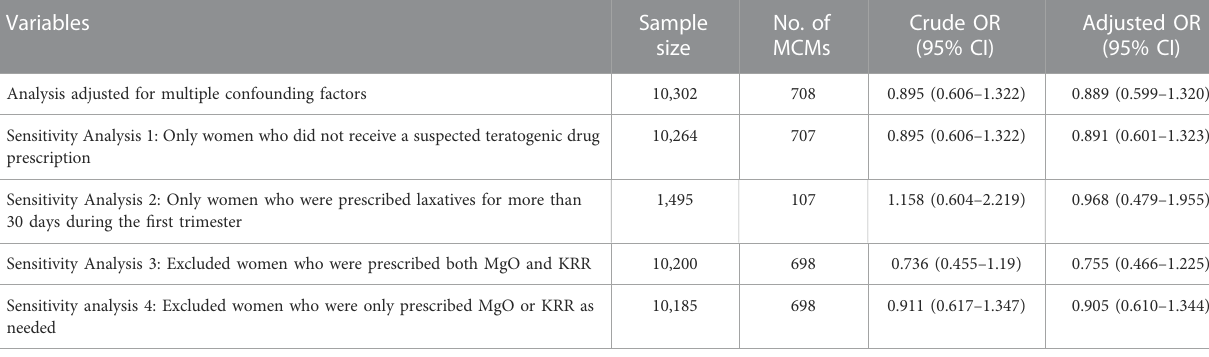
TABLE 4 Associations between the laxatives prescribed during the fi rst trimester of pregnancy and MCM risk.